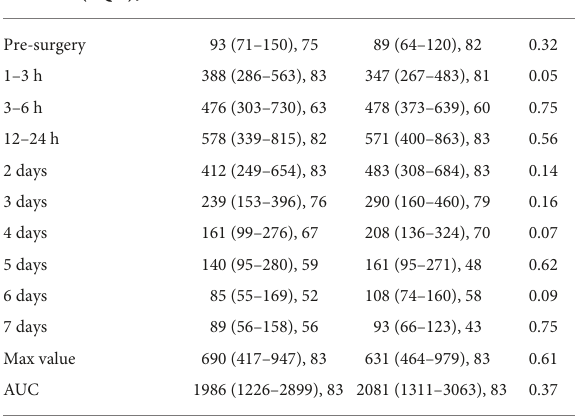
TABLE 4 Median values and interquartile ranges of creatine kinase in units/liter post-CABG after propensity